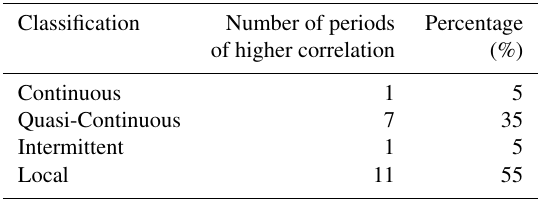
Table 4. Classification of the correlation distribution type between geomagnetic tail field B x component and AE index During HILD-